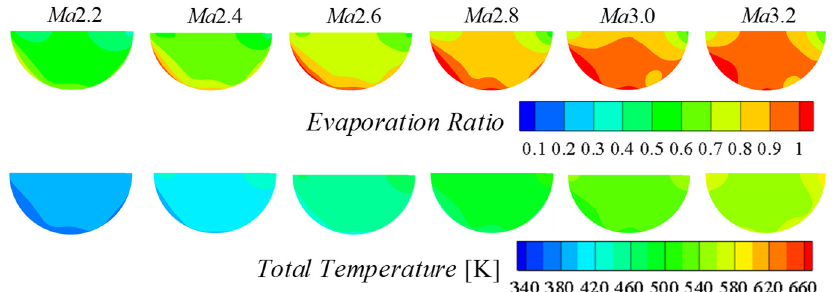
Figure 15. Contours of total temperature and evaporation ratio at different Mach numbers.